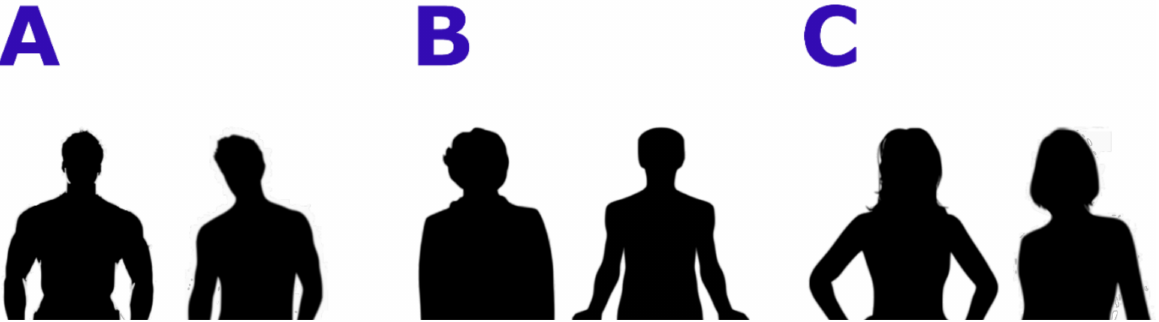
Figure 1. Examples of stimuli used during the Body Projection task. ( A ): male bodies; ( B ): neutral bodies, ( C ): female